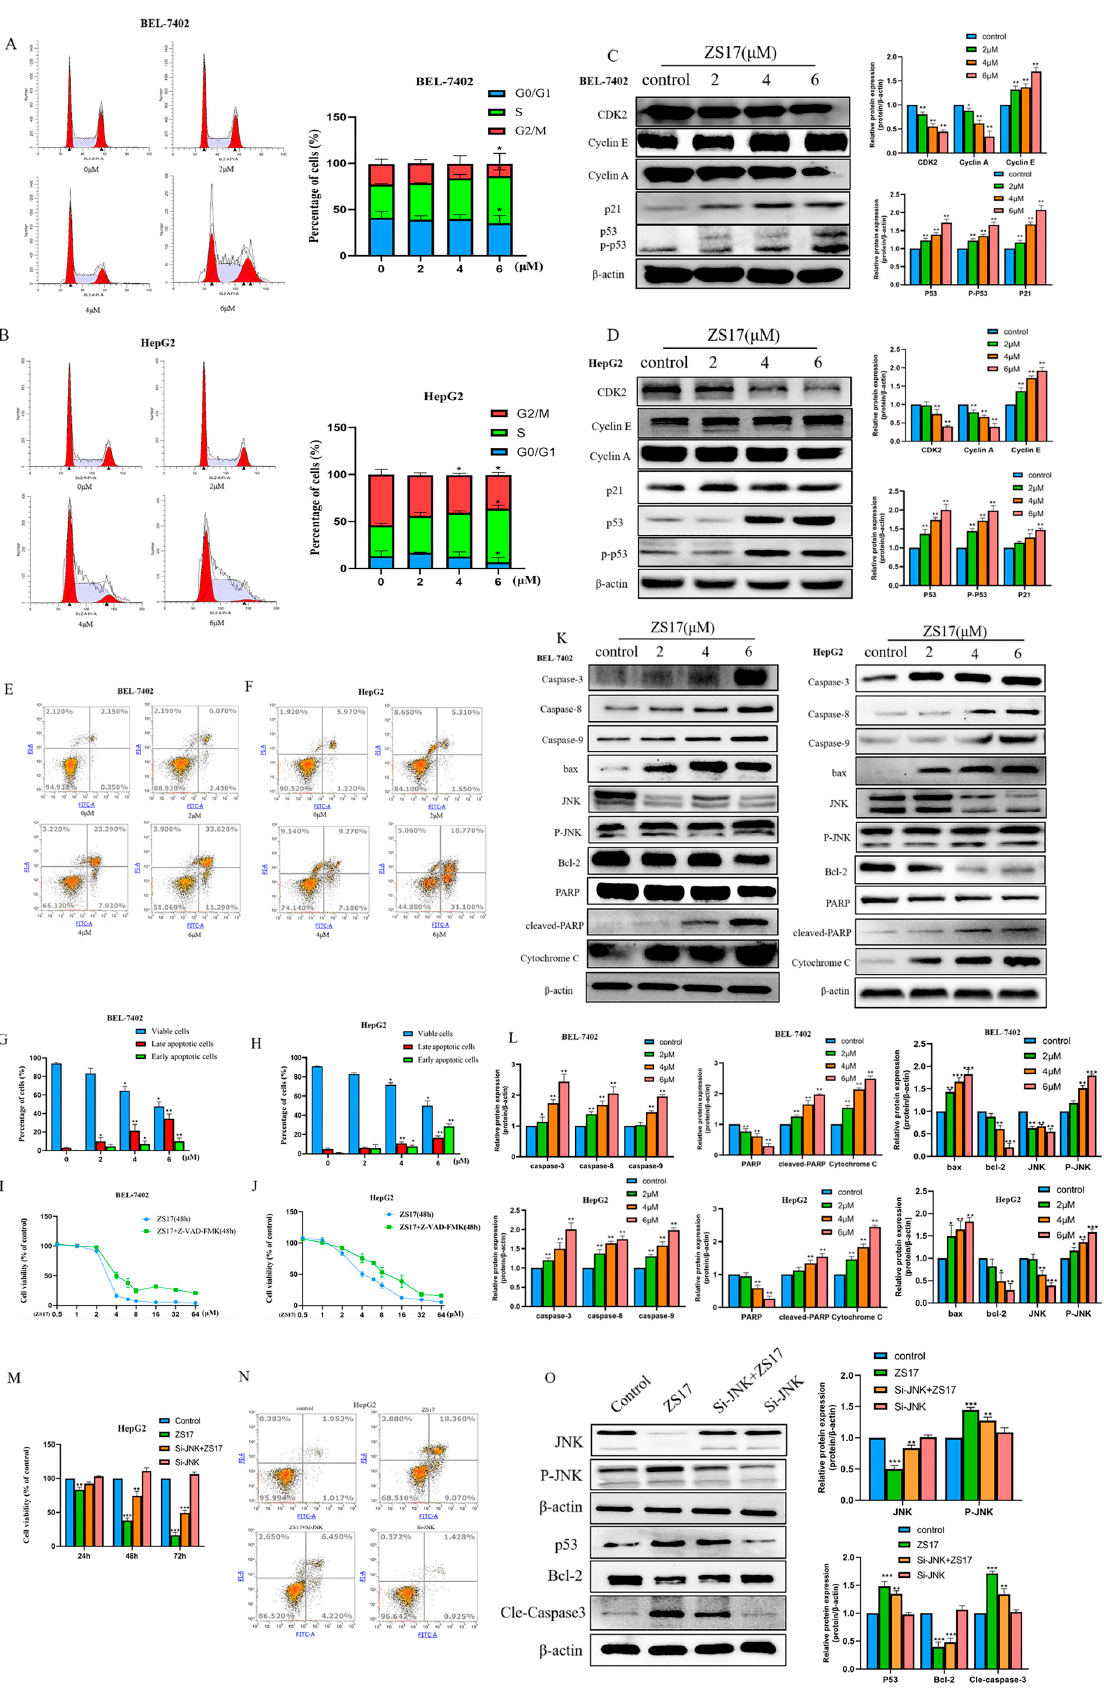
Figure 5. ZS17 inhibited cell cycle arrest in S phase and induced liver cancer cell apoptosis. ( A , B )